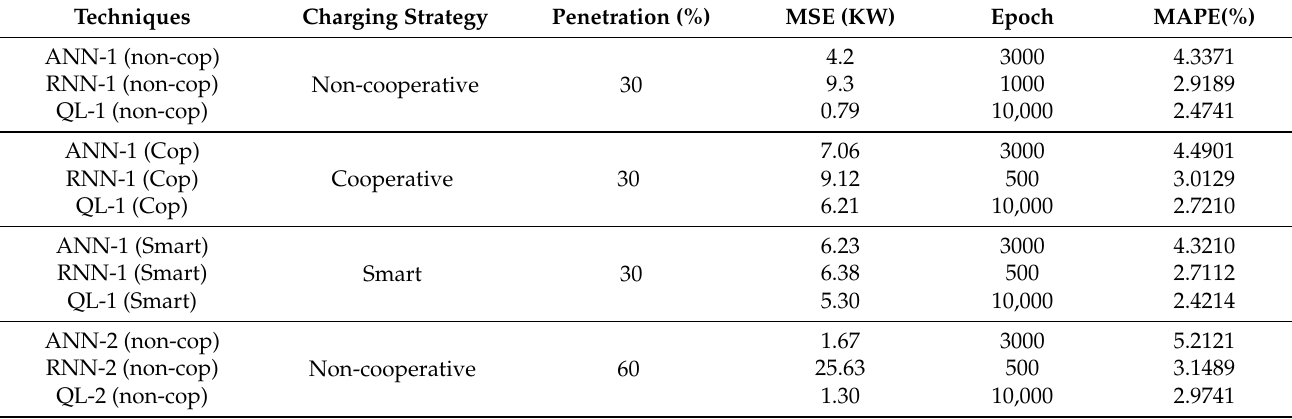
Table 5. Examining and projecting the charging demand of PHEVs utilizing ANN, RNN, and